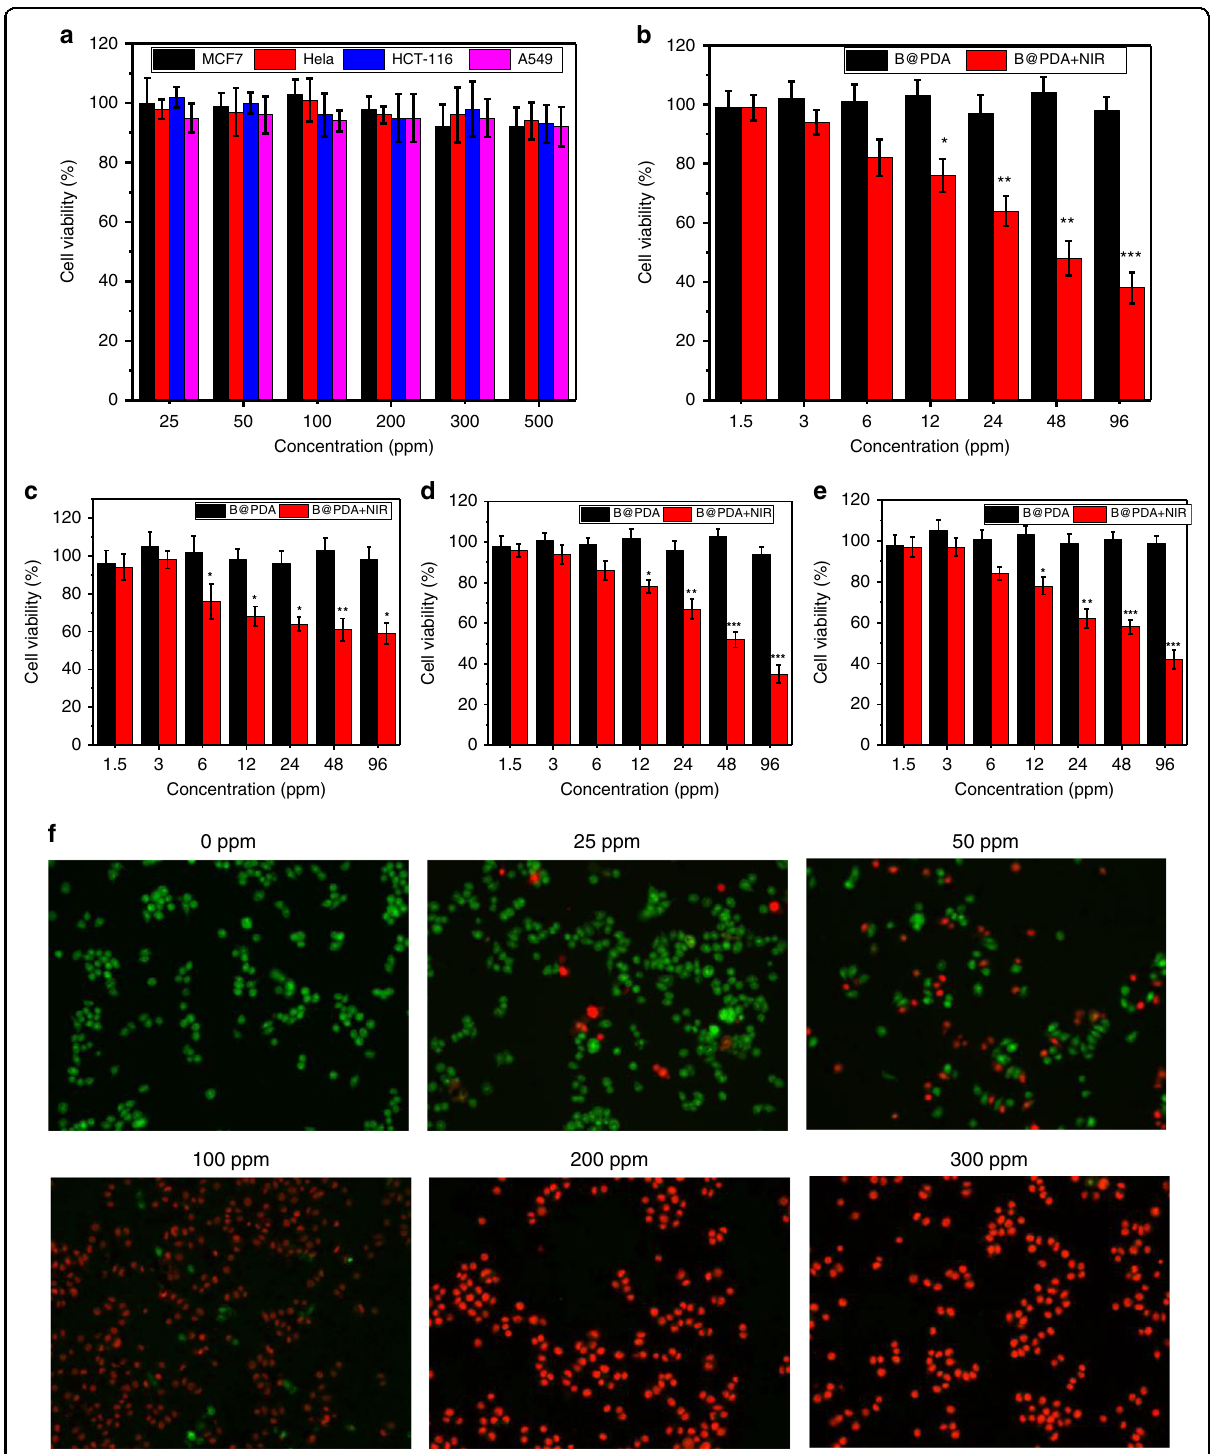
Fig. 5 Cytotoxicity and photothermal killing experiments of B@PDA. a Relative viability of HCT-116, HeLa, A549, and MCF7 cells after exposure in B@PDA-based medium (25 – 500 ppm) for 48 h. b Relative viability of HCT-116 cell incubated with B@PDA (1.5, 3, 6, 12, 24, 48, and 96 ppm) for 4 h and after photothermal treatment (1 W cm − 2 , 808 nm, 10 min,). c – e were treated with the same condition as ( b ) for HeLa, MCF7, and A549, respectively. f Corresponding laser scanning confocal microscopy (scale bars, 50 µm for all panels) of HCT-116 cells stained with PI (dead cells, red) and calcein AM (live cells,